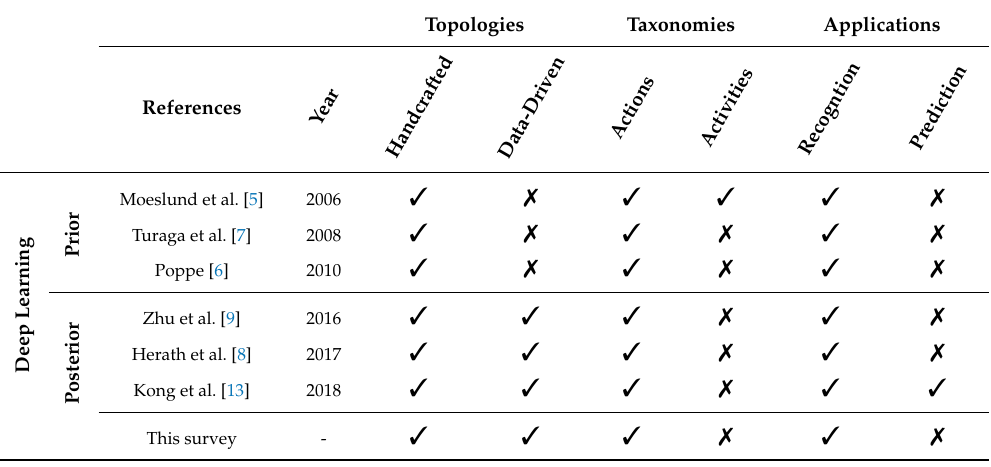
Table 1. Previous surveys on human behaviour